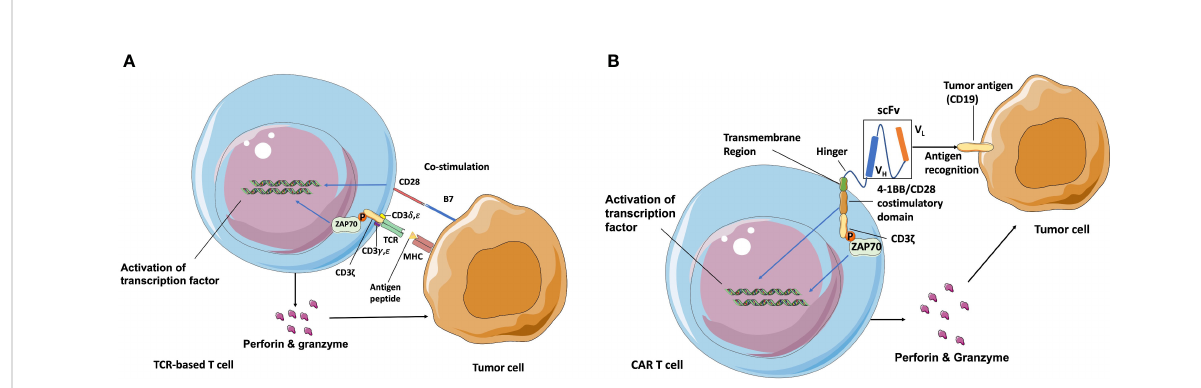
FIGURE 1 Schematic of TCR and CAR recognition and activation. (A) TCR is a heterodimer (one a and one b chain) connected by disul fi de bonds that is expressed in complex with intracellular CD3 molecules ( g , d , z , and e ). T cells are activated after TCR-recognizing peptides are presented by MHC molecules and co-stimulation of CD28 through B7 ligand. (B) CAR independently recognizes surface antigens with high af fi nity, unconstrained from MHC and co-stimulatory molecule expression on target cancer cells. The extracellular antigen-speci fi c scFv is typically generated from connected V H and V L chains from mAbs against target antigens. Various hinges and transmembrane domains are employed to link scFv and intracellular signaling molecules, which are the co-stimulatory domain (4-1BB/CD28) and CD3 z chain in second-generation CARs. CAR T cells are activated to release perforin, granzyme, and several kinds of cytokines after scFv recognition with surface antigens such as CD19 and from signaling through CD3 e -associated recruitment and the phosphorylation (P) of ZAP70 (13, 14). Blue arrow indicates the upregulation and activation of pathways. Black arrow indicates the molecules